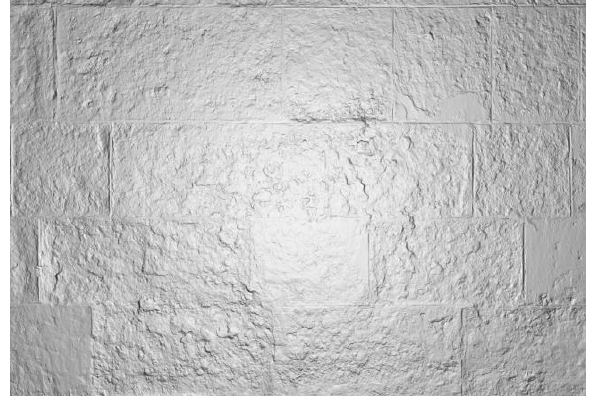
Figure 2. Orthoimage of the scan data of trial area 1 at Sint Baafs Cathedral in Ghent